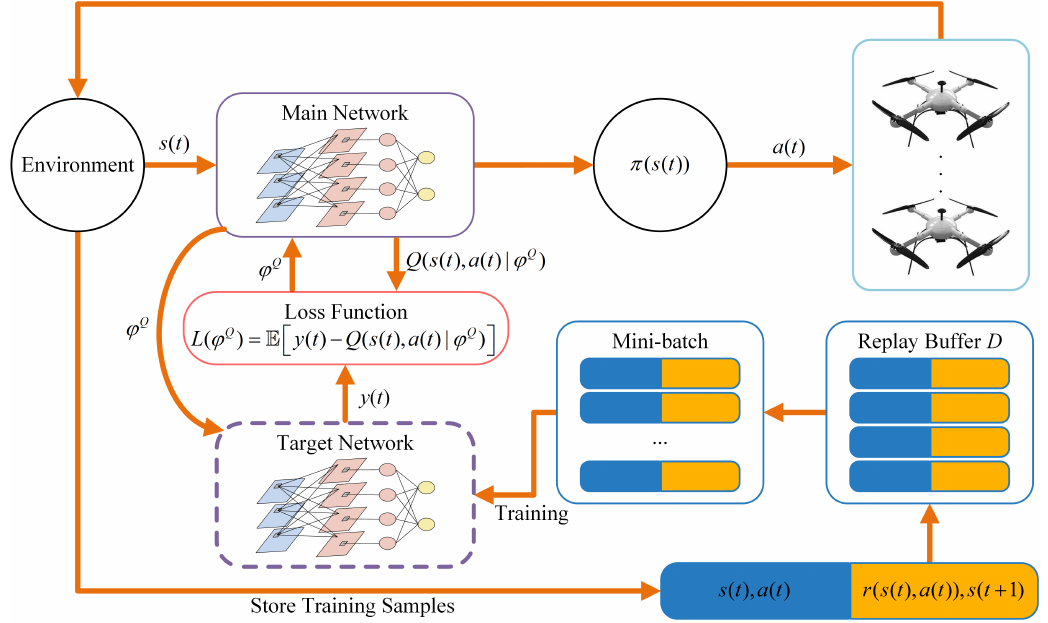
Figure 2. Deep reinforcement learning-based UAV cluster-assisted task-offloading algorithm (DRL- UCTO)